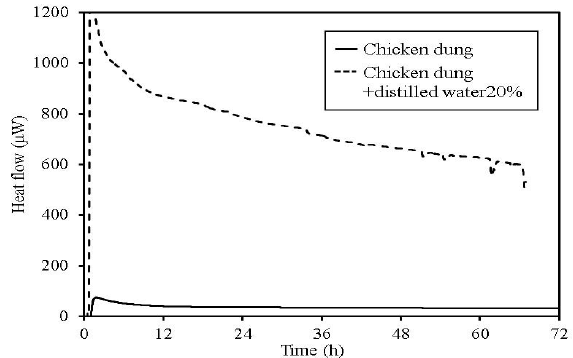
Figure 13. TAM calorimetry curves for chicken dung.